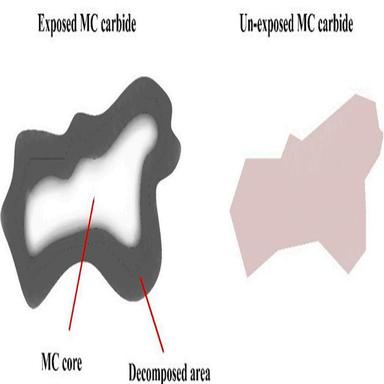
The schematic structure of the unexposed and degraded MC carbide.